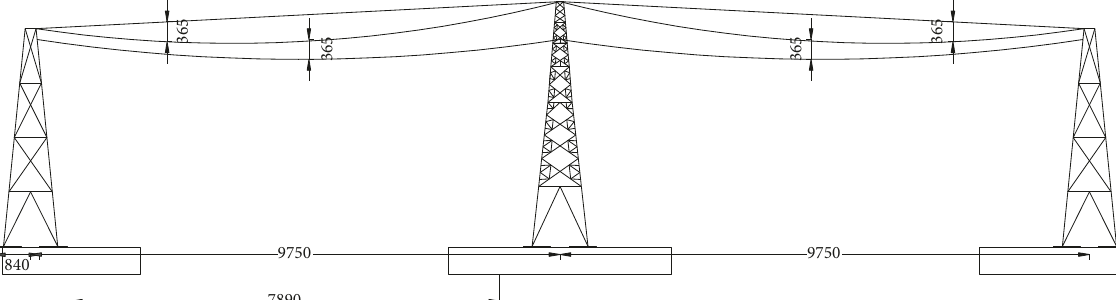
Figure 7: Elevation of the three-tower-two-line model.